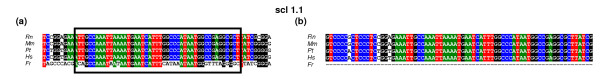
Comparison of two-step strategy with MAVID for the scl data set (a) Conserved block: alignment of the different scl orthologs. The conserved block as identified by BlockSampler - is marked with a boxed area. (b) Visualization of the MAVID alignment of the corresponding region. The dashed line denotes a gap in the alignment. Rn, Rattus norvegicus; Mm, Mus musculus; Pt, Pan troglotydes; Hs, Homo sapiens; Fr, Fugu rubripes.